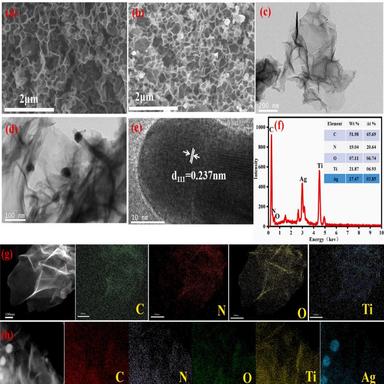
(a) SEM image of 3D Ti3C2; (b) SEM image of 3D Ti3C2/Ag; (c) TEM image of 3D Ti3C2; (d) TEM image of 3D Ti3C2/Ag; (e) HR-TEM image of 3D Ti3C2/Ag; (f) EDS spectra of 3D Ti3C2/Ag; (g) Elemental mapping images of 3D Ti3C2; (h) Elemental mapping images of 3D Ti3C2/Ag.